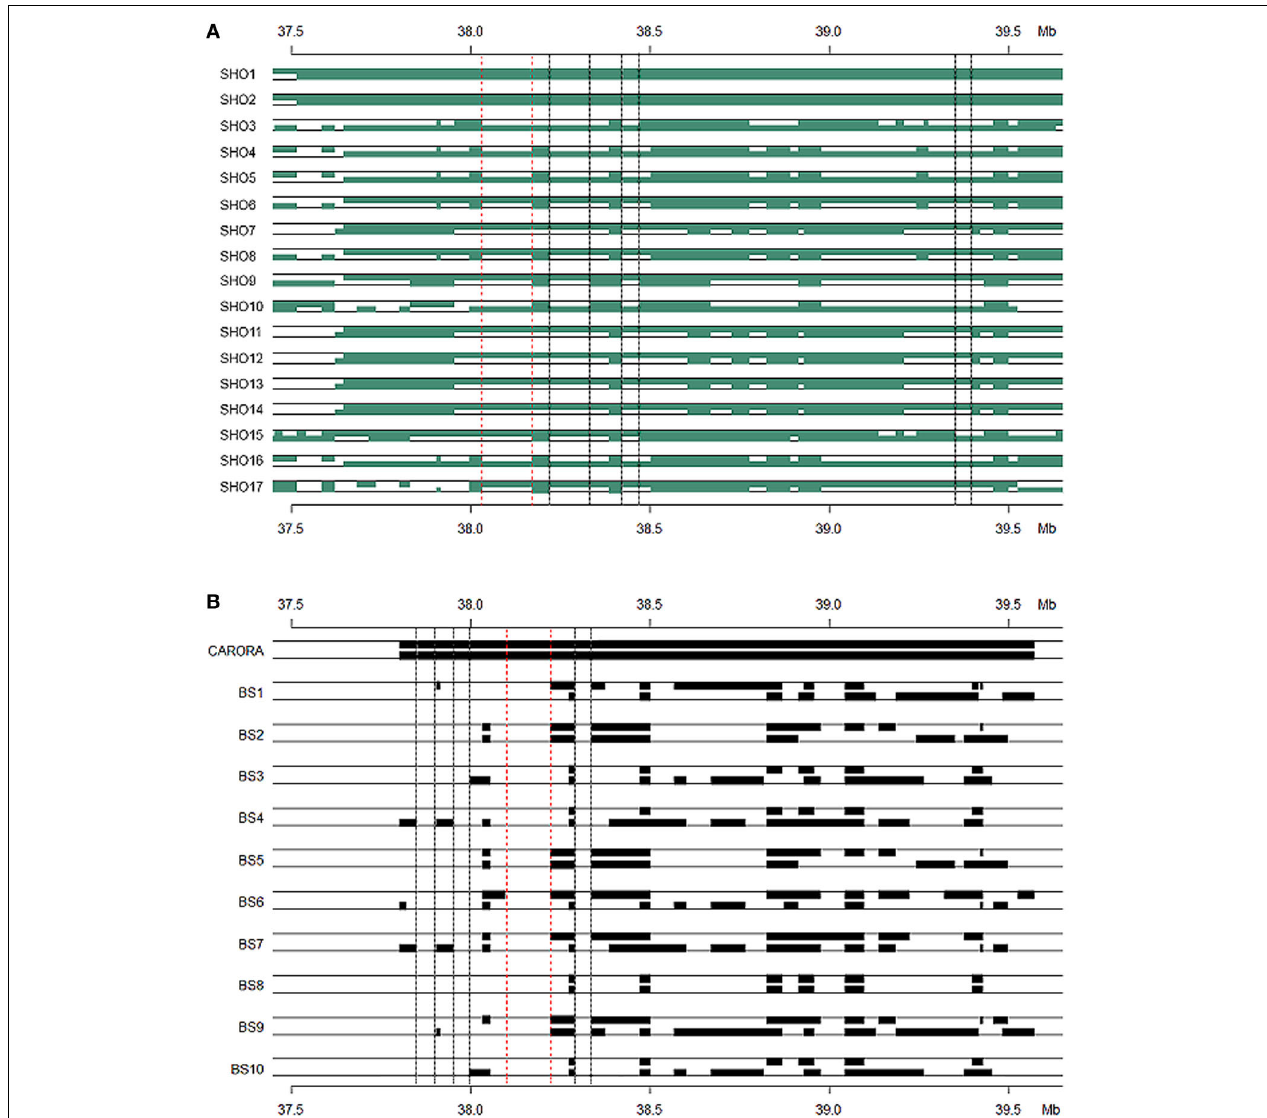
FIGURE 6 | Haplotype blocks of Senepol-Holstein cross-bred and Caroro/Brown Swiss cattle based on identity by state analysis. Animals expected to be heterozygous at SLICK are shown with each block representing a common haplotype greater than ten SNPs. The dotted lines indicate consensus regions among the slick-haired animals potentially containing the SLICK mutation. The region between the red dotted lines are the most likely candidate regions with those between black dotted lines